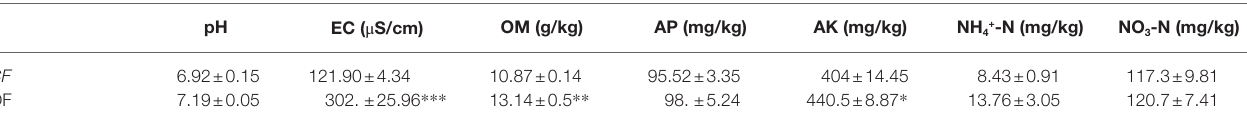
TABLE 1 | Soil physicochemical properties under different fertilization management